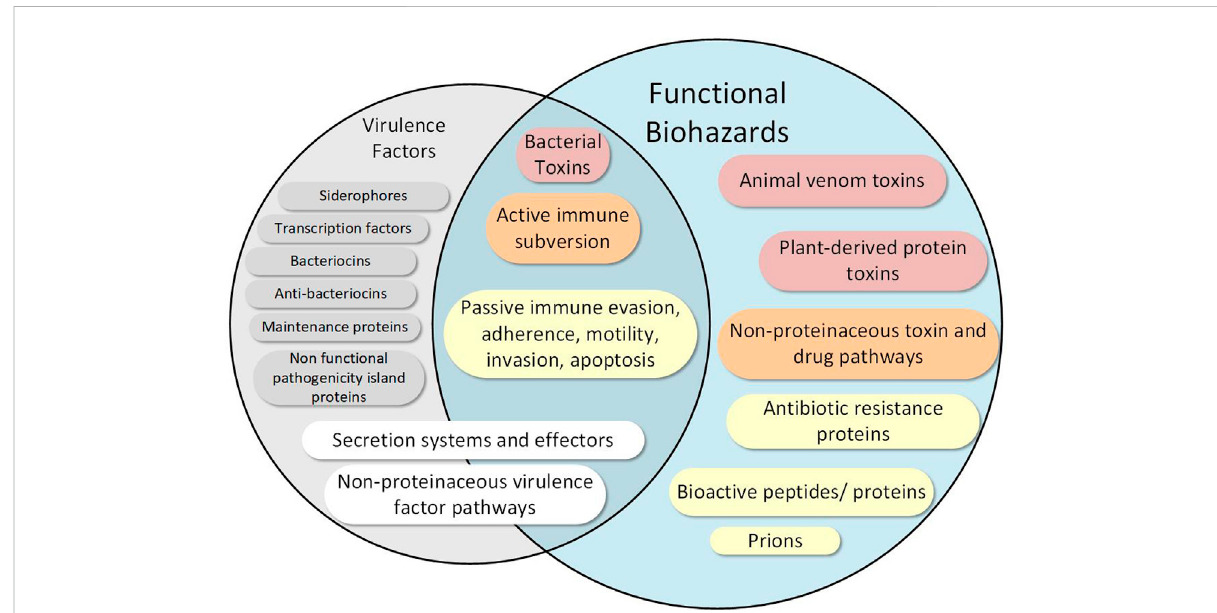
FIGURE 2 Functional biological hazards are differentiated from and include several functions beyond virulence factors. While some hazardous functions overlap with virulence factors, we de fi ne several hazardous functions outside the traditional de fi nition of virulence factors. Many virulence factors that may becontained inavirulent organisms,such as siderophoresand transcription factors,are not considered hazardous functionsas they do not directlyanduniquelyperformhazardousfunctions.Hazardousfunctionsarefurtherdescribedinthetextandarecolorcodedaccordingcoarse functional metadata groups as follows: Red — functions that do direct damage to cells such as toxins; Orange — functions involved in active host subversion or those involved in nonproteinacous toxin and drug pathways; Yellow — other virulence factors uniquely involved in pathogenicity (e.g., invasion), non-virulence factors that may contribute to detrimental host response (e.g., bioregulators and antibiotic resistance proteins), and prions; White — virulence factors that may also participate in non-hazardous microorganism functions; Gray — virulence factors that do not have a direct hazardous function. Note that the fi gure is non-exhaustive.